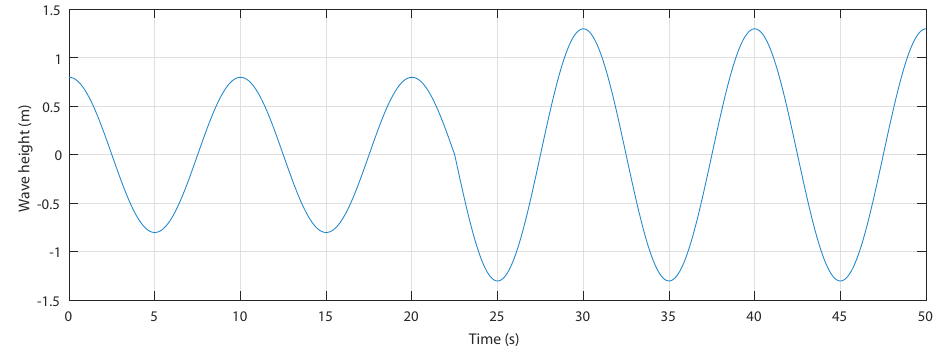
Figure 13. Considered waves as input to the wave-to-wire model